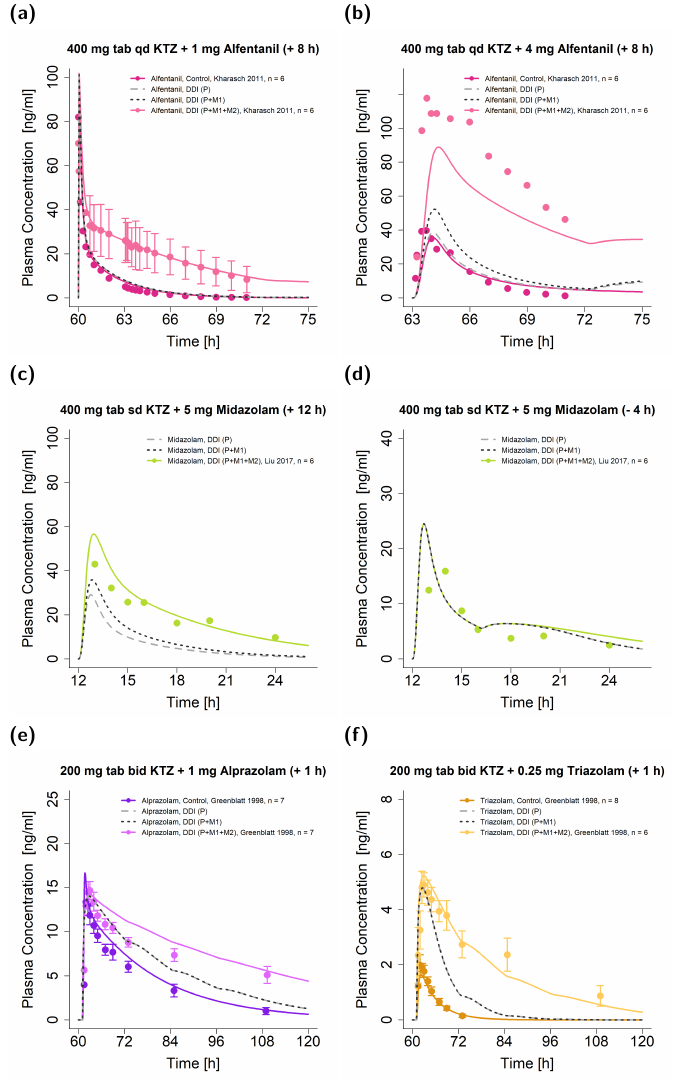
Figure 6. Ketoconazole DDI model simulations. Predicted (as compared to observed) plasma concentration-time profiles are illustrated for DDIs with the victim drugs alfentanil ( a , b ), midazolam ( c , d ), alprazolam ( e ), and triazolam ( f ) [17,19,56]. The time of victim drug intake was 8 or 12 h after ( a – c ), 4 h before ( d ), and 1 h after ( e , f ) ketoconazole administration. Illustrated are DDI predictions (i) with the parent compound alone (P) (long dashed line in grey), (ii) with the parent compound and M1 (P + M1) (dashed line in black), and (iii) with the parent compound and both metabolites (P + M1 + M2) (solid line in a brighter colored shade) alongside their respective reference profiles (solid line in a darker colored shade). Corresponding observed data are shown as dots (arithmetic mean ± standard deviation (if available)). The dosing of ketoconazole–alfentanil DDIs ( a , b ) was normalized to the respective control to highlight the comparison of DDI and control, while the Supplementary Materials show the data from the respective studies that were simulated as